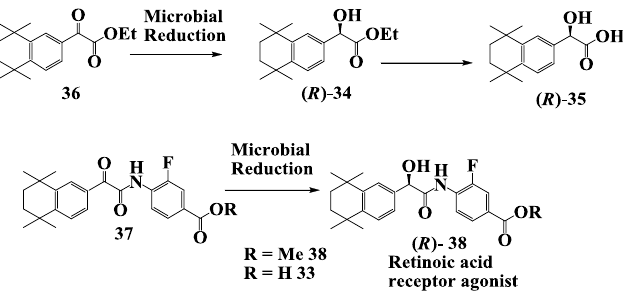
Figure 10. Retinoic acid receptor agonist: Enzymatic preparation of 2-( R